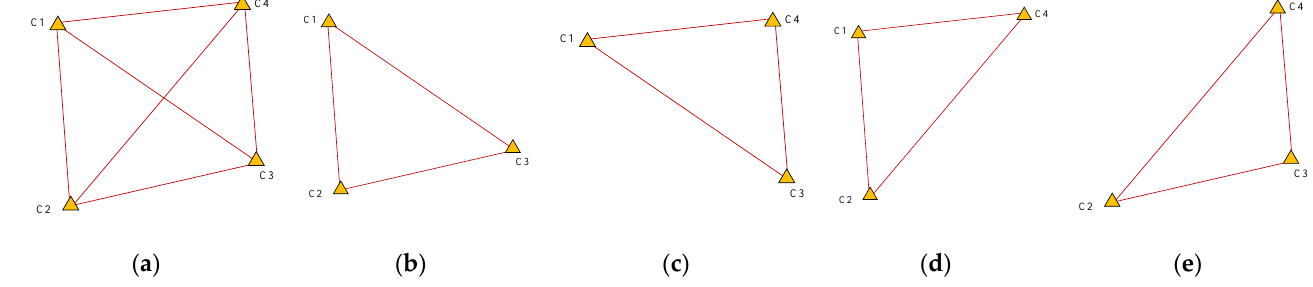
Figure 10. The combinations of control points. ( a ) Points C1, C2, C3, and C4. ( b ) Points C1, C2, and C3. ( c ) Points C1, C3, and C4. ( d ) Points C1, C2, and C4. ( e ) Points C2, C3, and C4. Table 2. The mean and standard deviation of mutual ranging results between control points. Point 1 Point 2